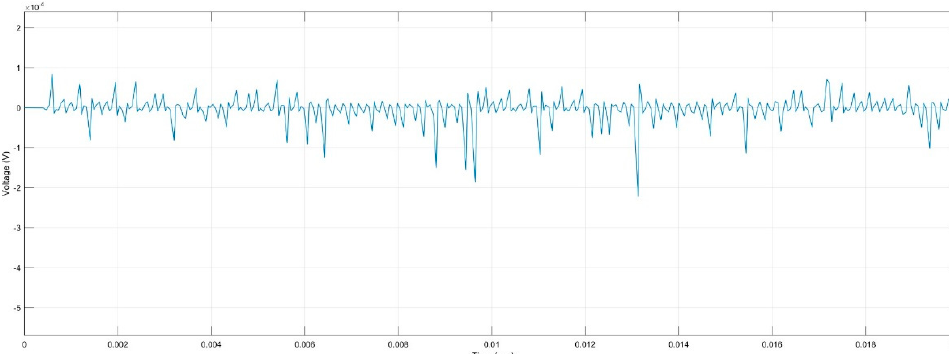
Figure 4. PD Activity for ER, 5 kV, h, 2 r.